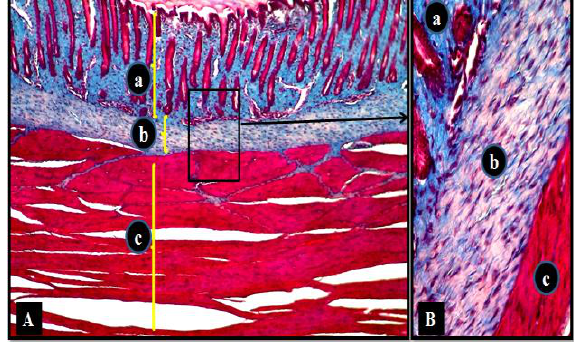
Figure, 5: A. Ventriculus wall of pigeon cuticle (a), mucosa (b), submucosa (c), muscularis (d), (X100, Masson's Trichrome). B. higher magnification of same layers in A, (X400, Masson's Trichrome).